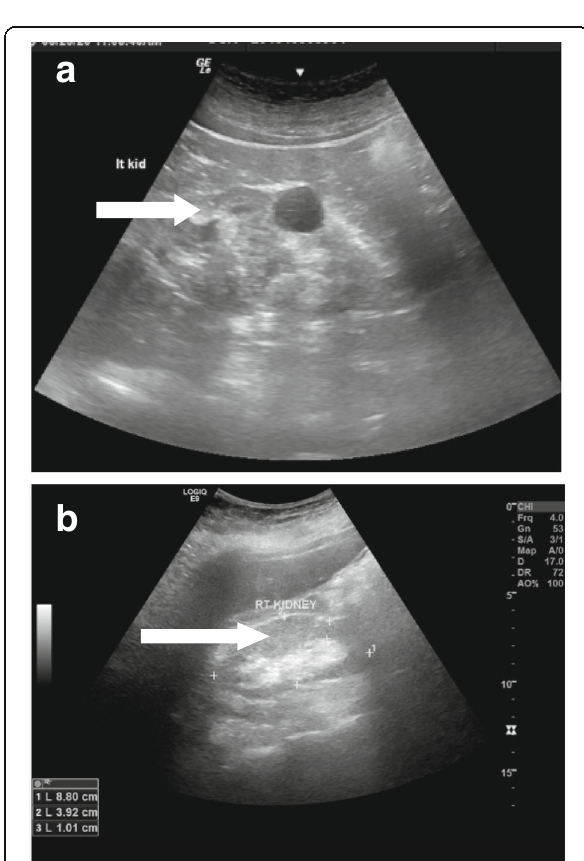
Fig. 2 ( a and b ) Nephropathy in COVID19 intensive care patient with increased parenchymal echogenicity (open white arrows in a and b ) still with parenchymal thickness and renal measurements within normal range, a midzonal simple cortical cyst is noted in the left kidney (arrow in a